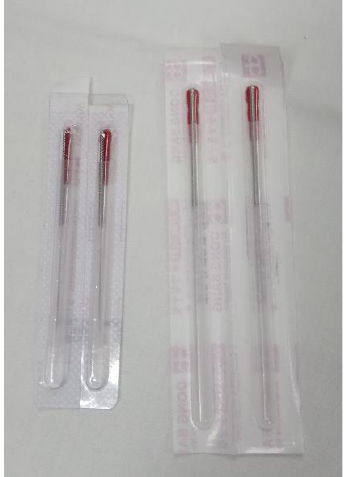
Figure 1. The needles used with the Deep Dry Needling Group are shown on the left; the needles used with the Placebo Needling Group are shown on the